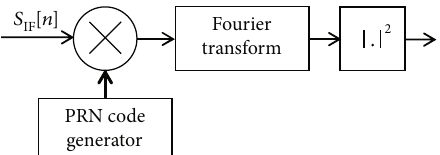
Figure 8: Simpli fi ed block diagram of the parallel acquisition method in Doppler frequency used in piNAV acquisition